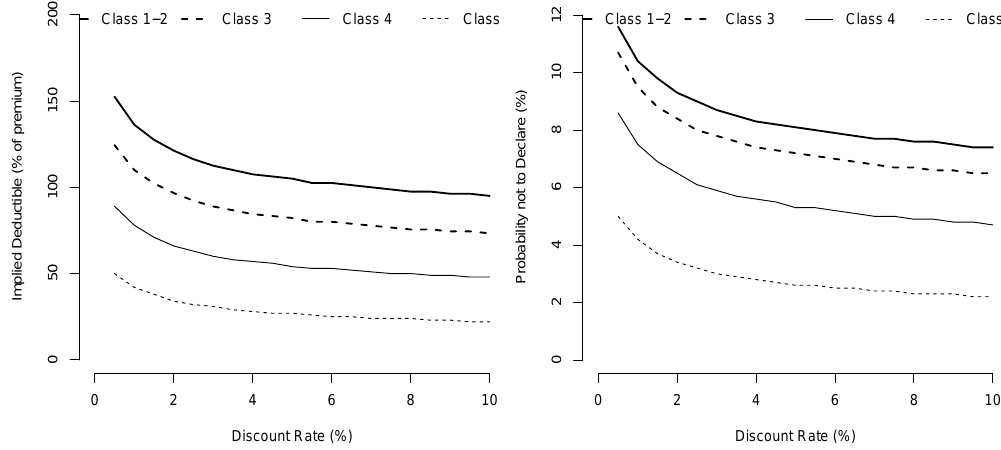
Figure 2. Value of the Deductibles, d (cid:63) s (expressed as a percentage of the premium P s ) and probability not to declare an accident, 1 − π (cid:63) s = P [ L < d (cid:63) s ] as a function of the discount rate r .